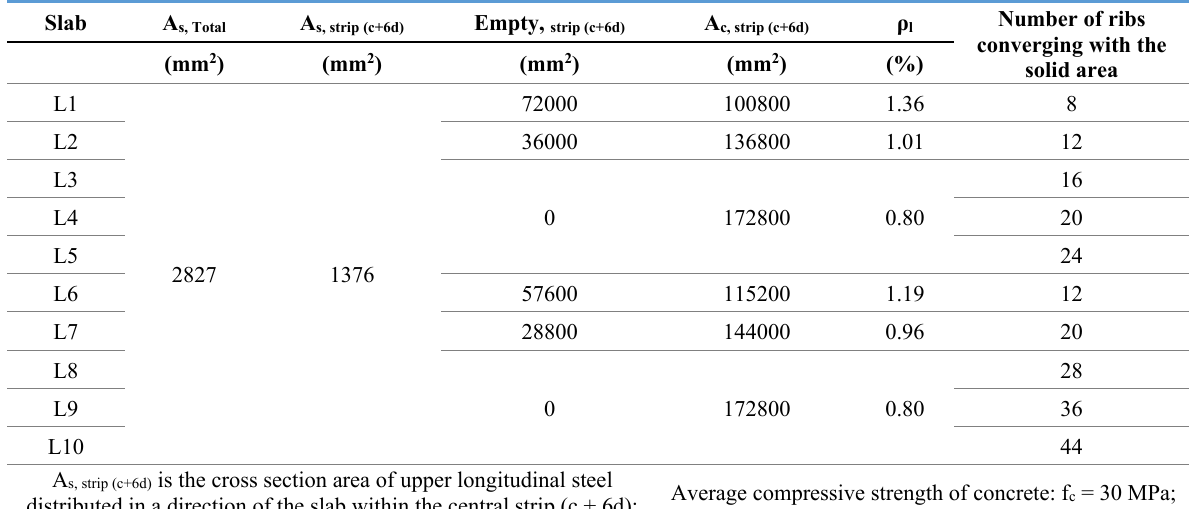
Table 2. Data from analyzed slabs